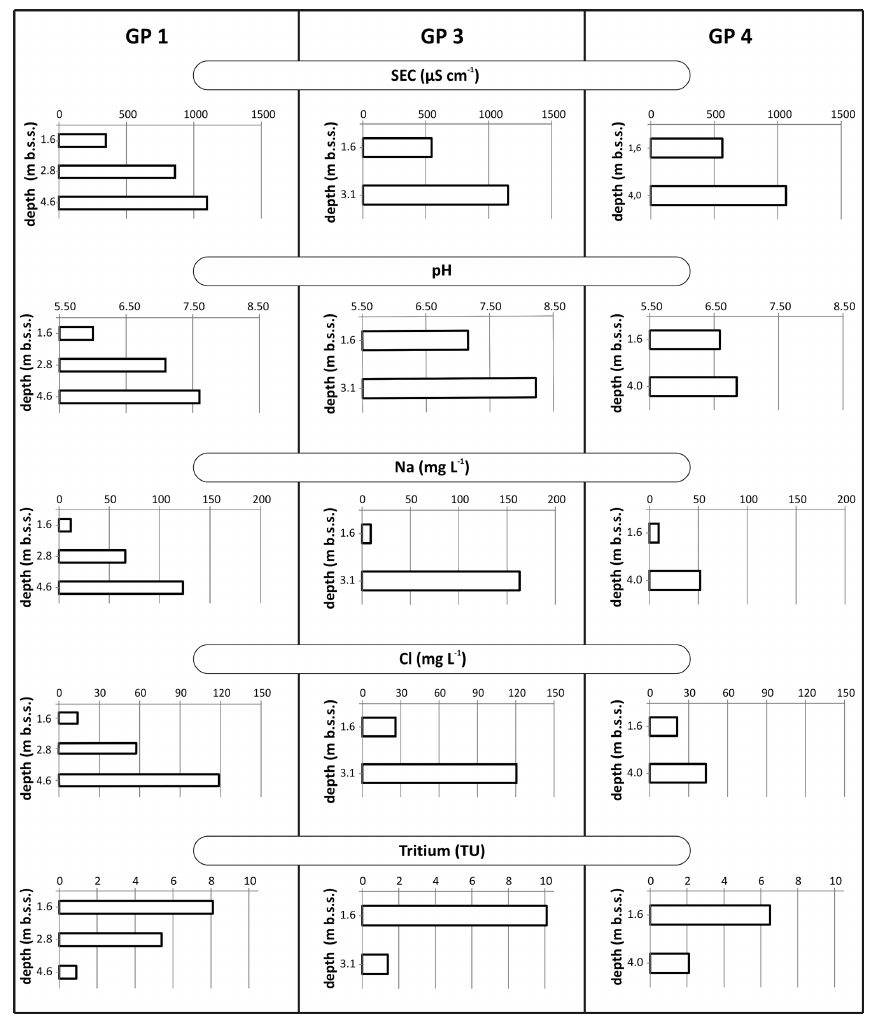
Figure 8. Depth stratification of pH, conductivity, Cl, Na and tritium content in the shallow Quaternary aquifer underlying the Wielkie Błoto fen and adjacent parts of the Niepolomice Forest. Water samples were collected with the aid of Geoprobe ® device. Location of sampling sites (GP1, GP3, GP4) is shown in Fig.